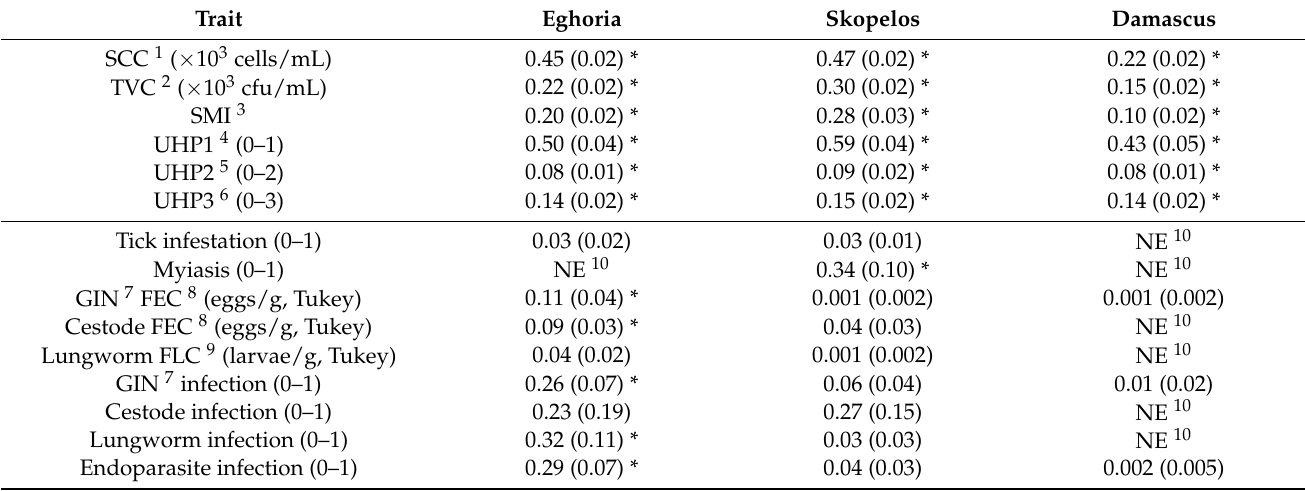
Table 5. Repeatability estimates (standard error in parentheses) for health (udder health and para- sitism) traits in Eghoria, Skopelos, and Damascus goats.